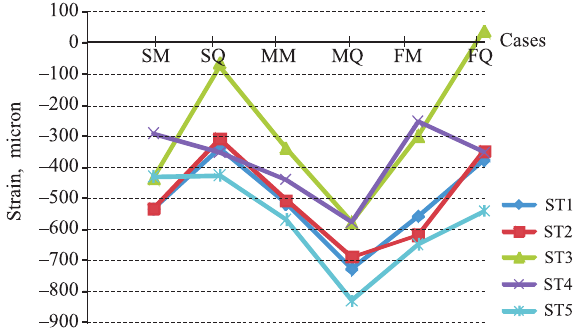
Fig. 20. Effect of vehicle location on slab strain